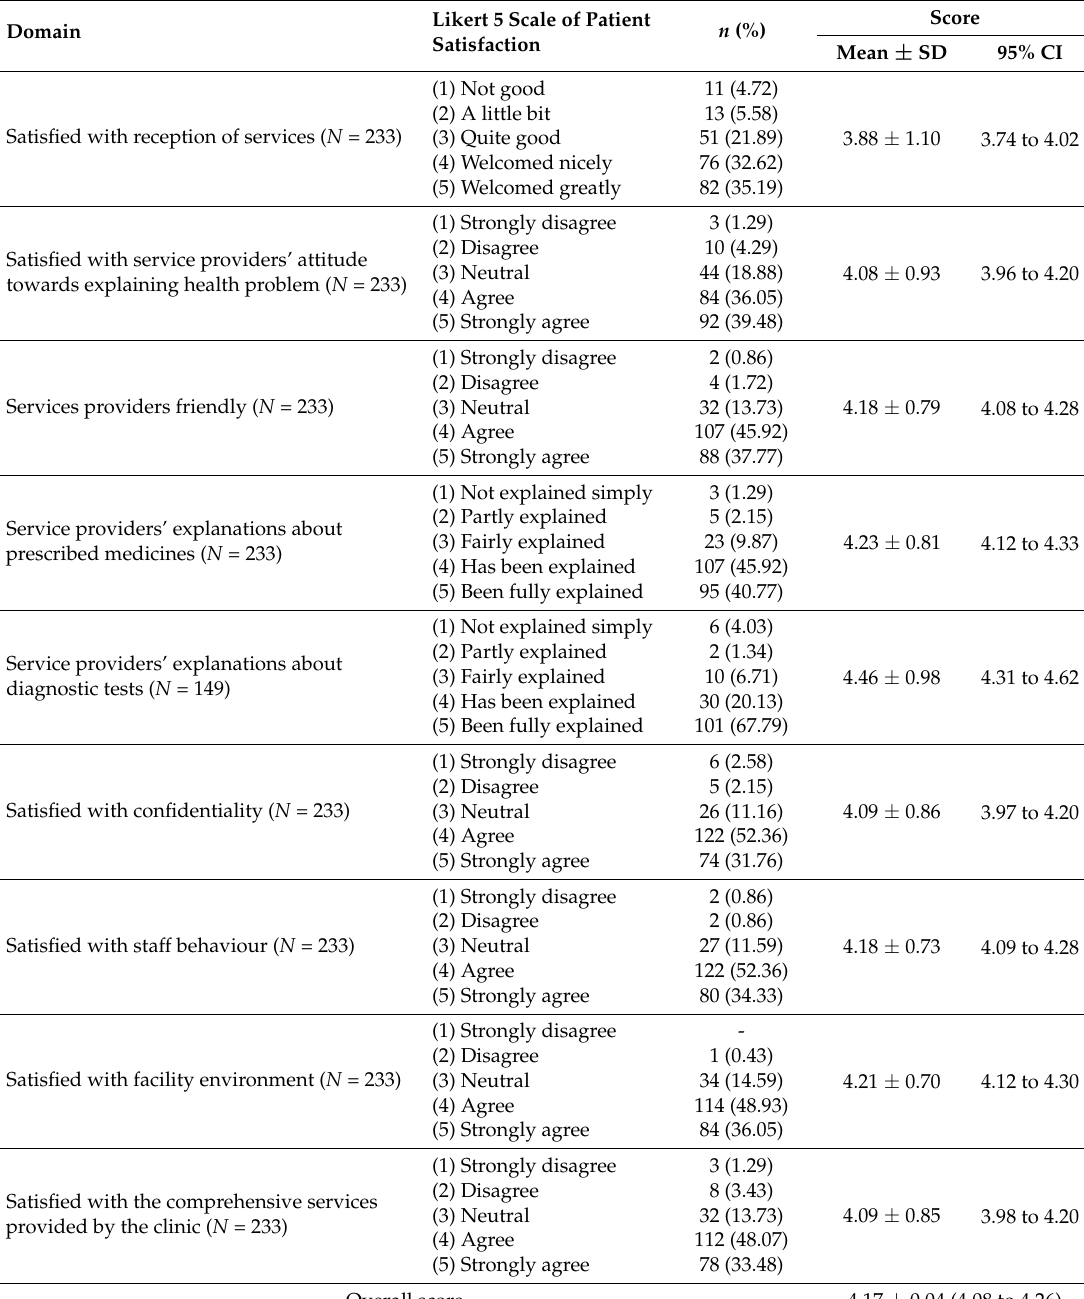
Table 3. Health services provision-related satisfaction on self-financed health